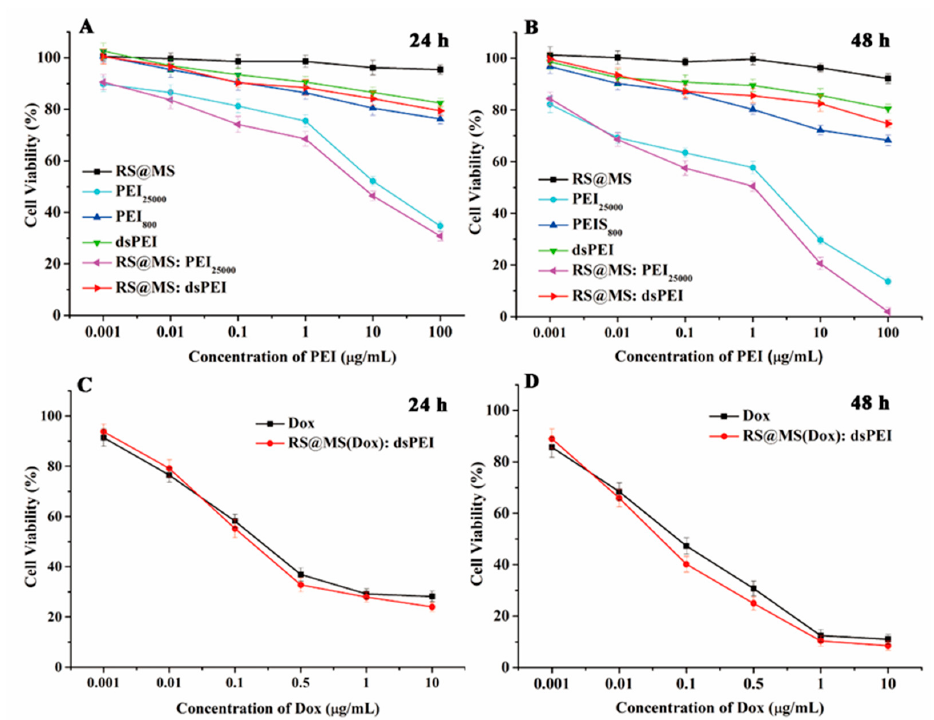
Figure 5. ( A , B ) in vitro cytotoxicity of RS@MS, PEI 25000 , PEI 800 , dsPEI, RS@MS:PEI 25000 , and